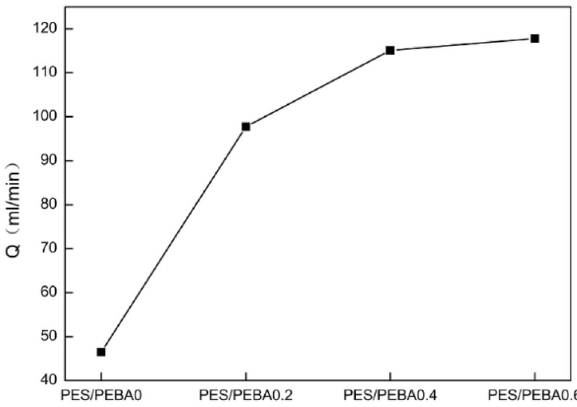
Figure 6. Gas flow rate of modified PEBA membranes with different fumed silica